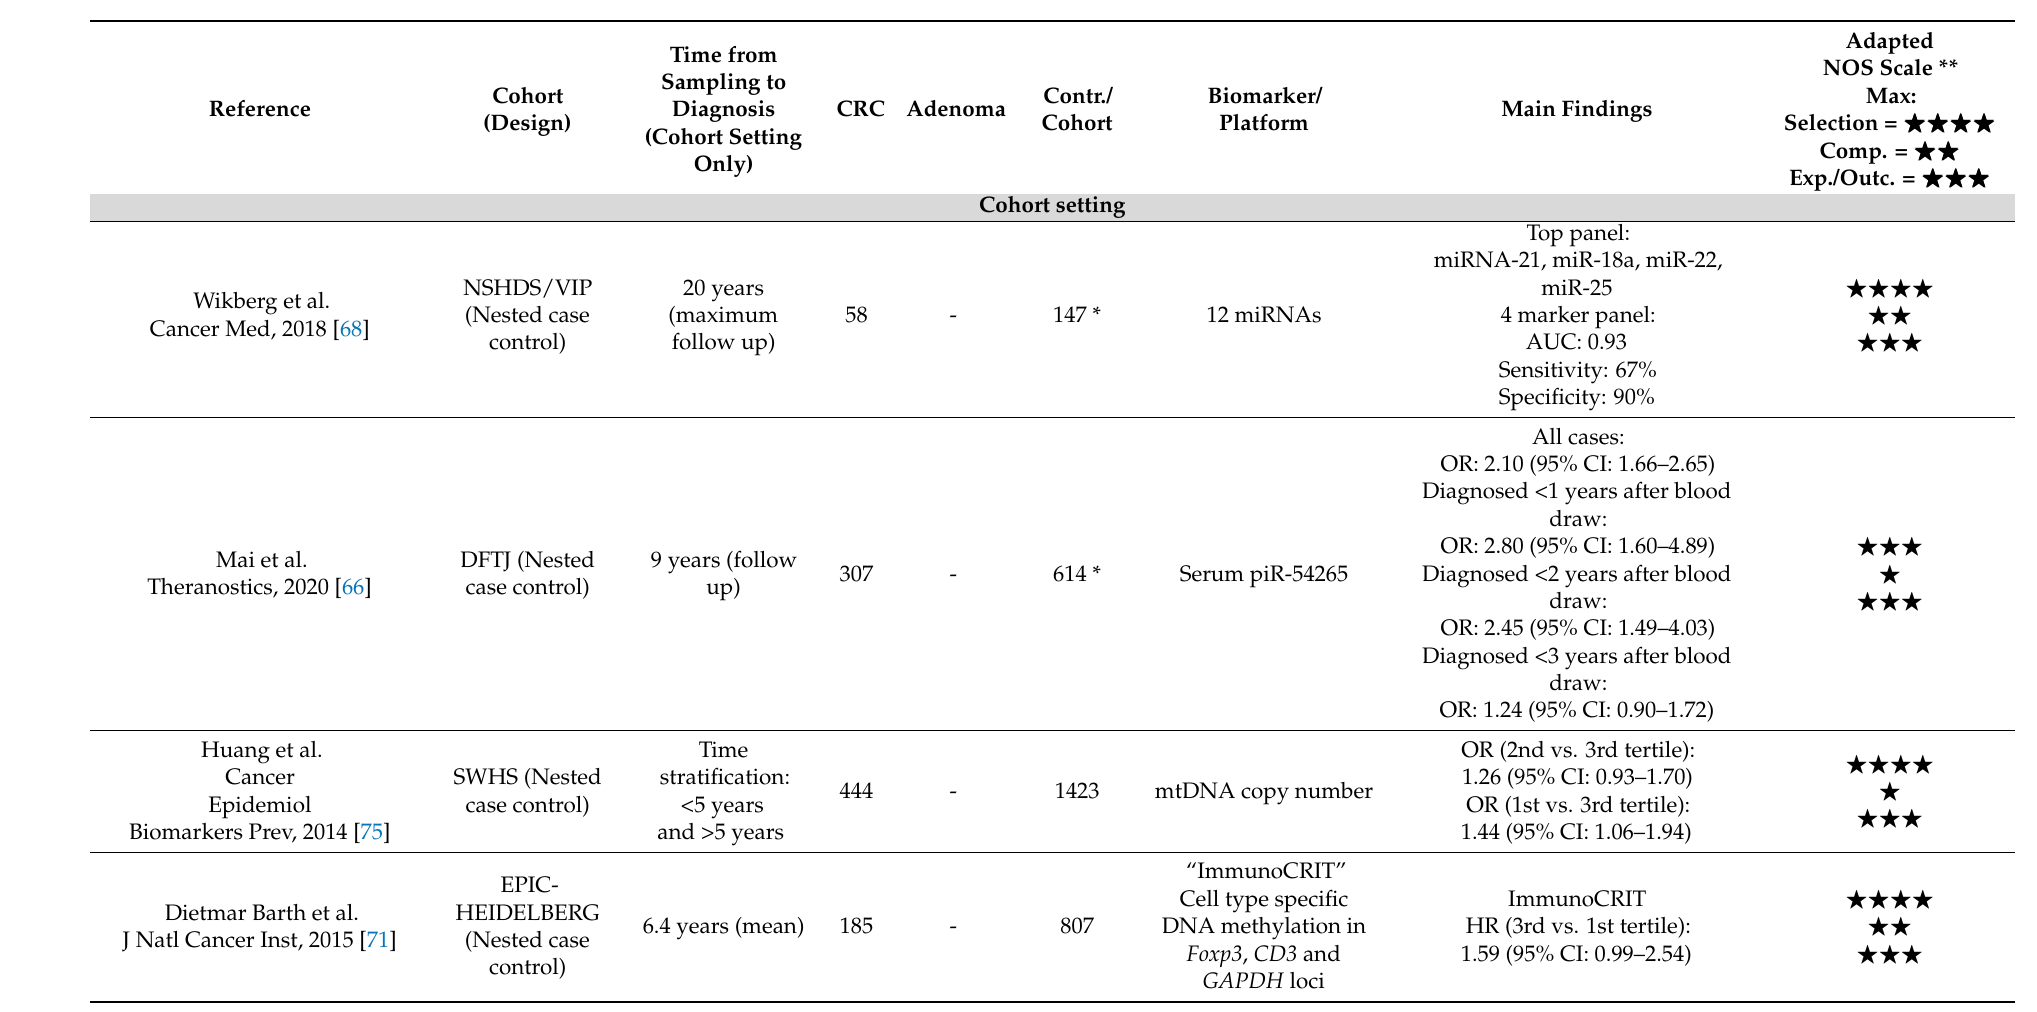
Table 4. Studies of nucleic acids analyzed in pre-diagnostic blood samples (collected in prospective cohort or general screening settings) for the purpose of risk prediction or early diagnosis of colorectal